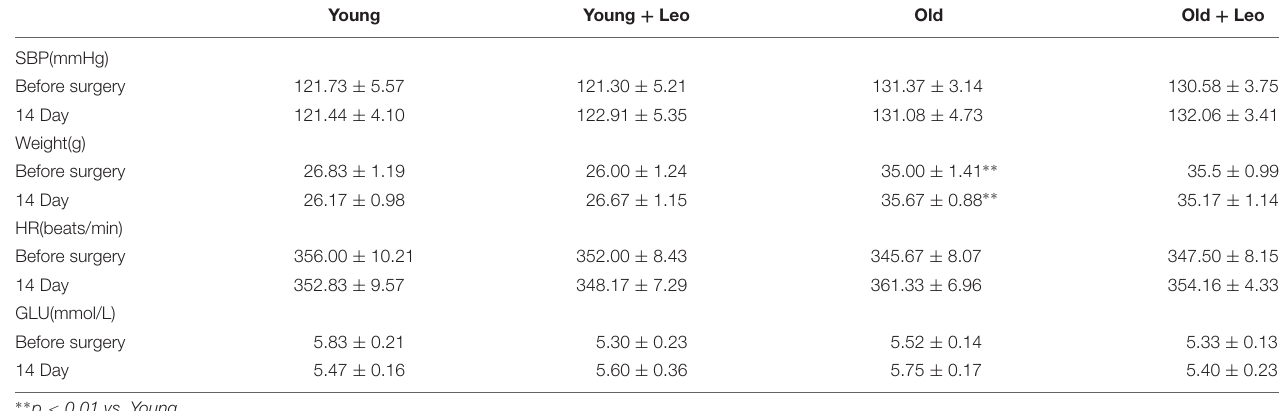
TABLE 1 | Effect of leonurine on physiological parameters in young and old mice.